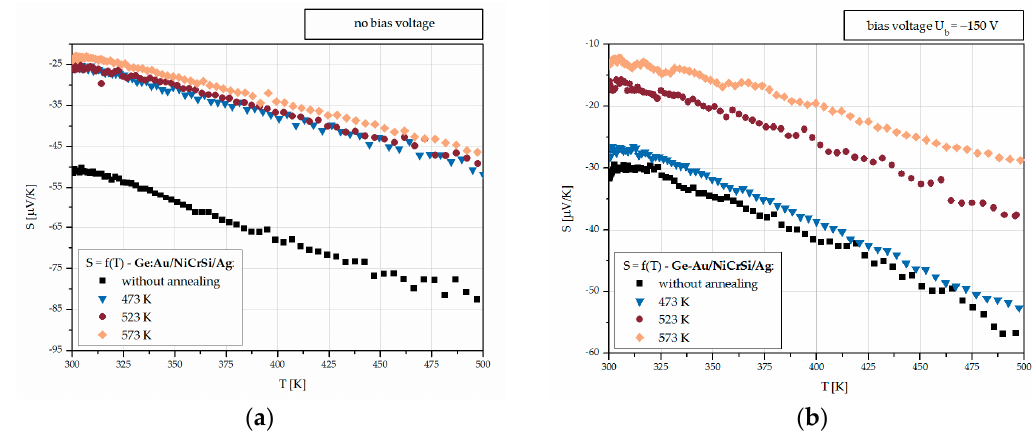
Figure 7. The Seebeck coefficient S as a function of the structure’s temperature T before and after annealing: ( a ) Ge–Au/NiCrSi/Ag test structures deposited in the sputtering process without external bias voltage; ( b ) Ge–Au/NiCrSi/Ag test structures deposited in the sputtering process with external bias voltage.